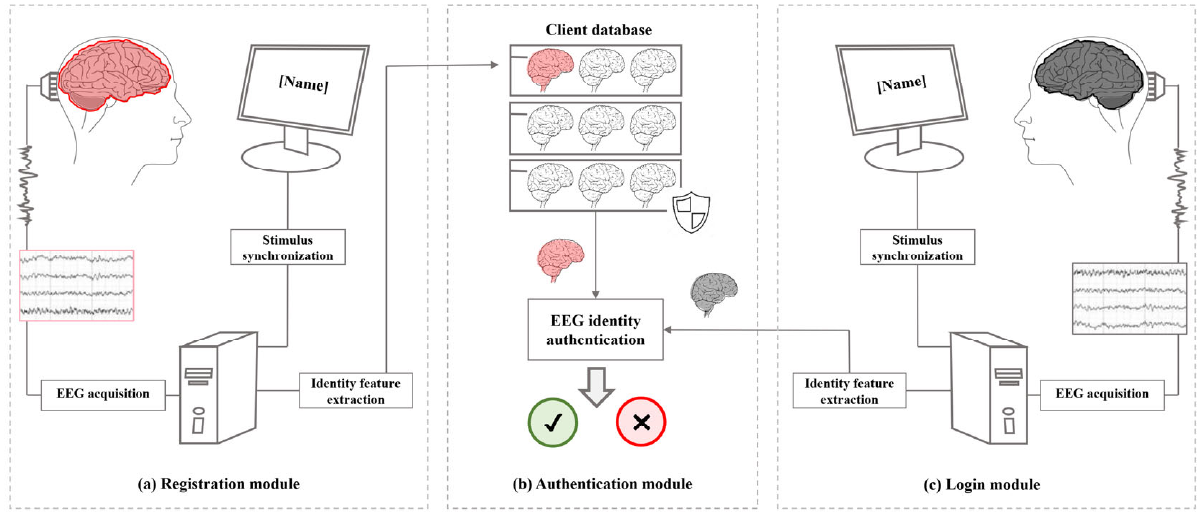
Figure 3. Flow chart of the brainprint recognition